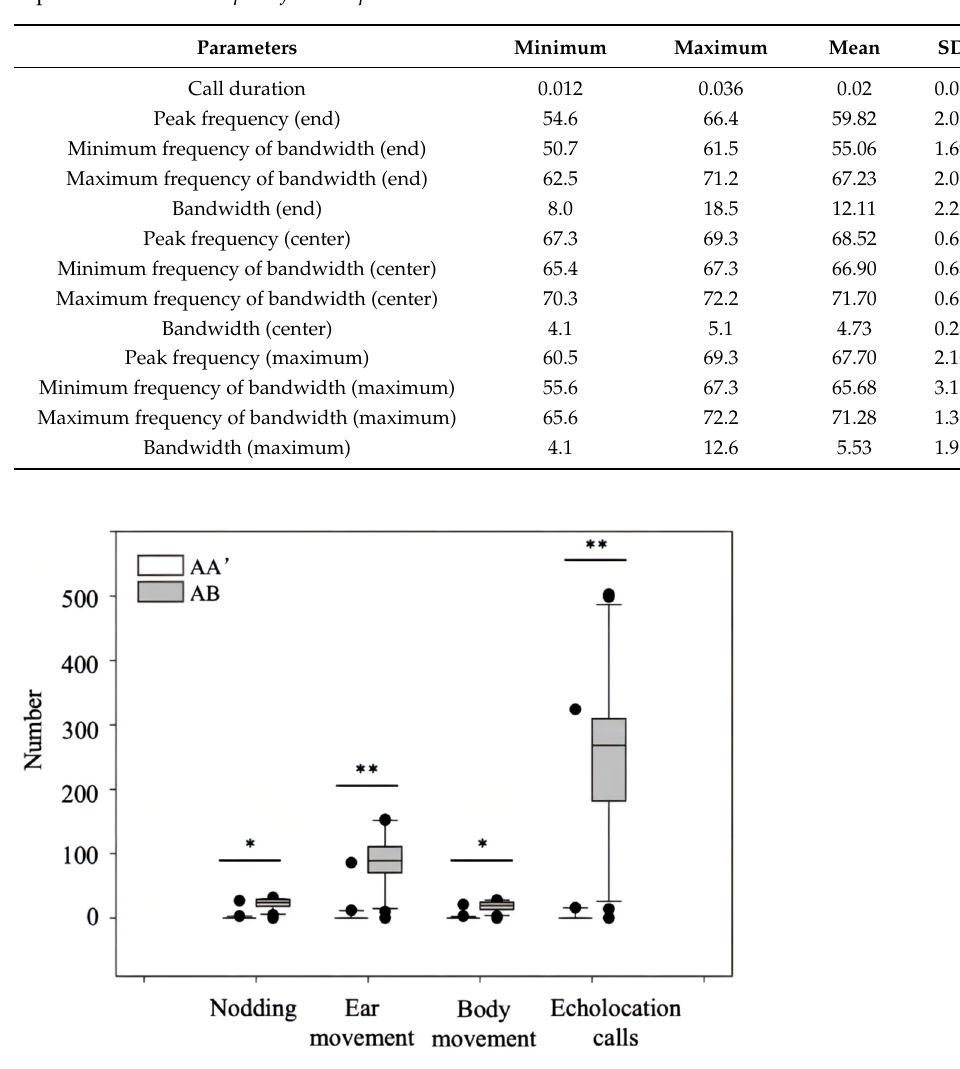
Figure 7. Results of the echolocation call individual identification habituation-dishabituation play- back experiment for Rhinolophus ferrumequinum . A and B represent two different individuals. AA’ represents a change from the habituated sound file of individual A to another sound file of individual A. AB represents a change from the habituated sound file of individual A to the dishabituated sound file of individual B. * denotes p < 0.05, and ** denotes p < 0.01.